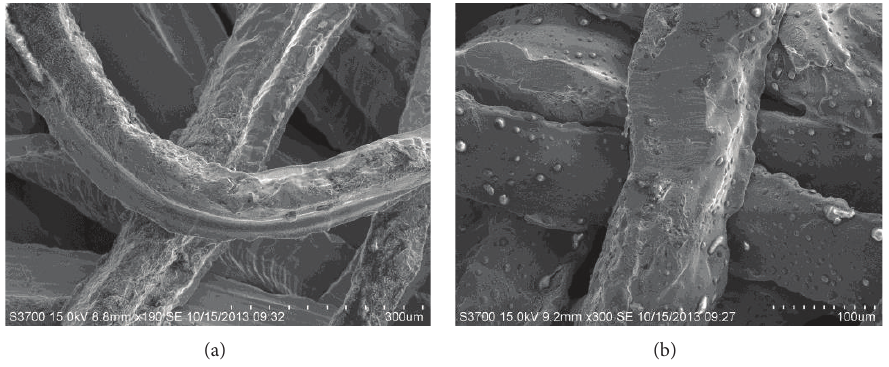
Figure 4: Surface morphologies of SSSFF sintered at 1200 ∘ C (a) for 120min and (b) for 240 min.